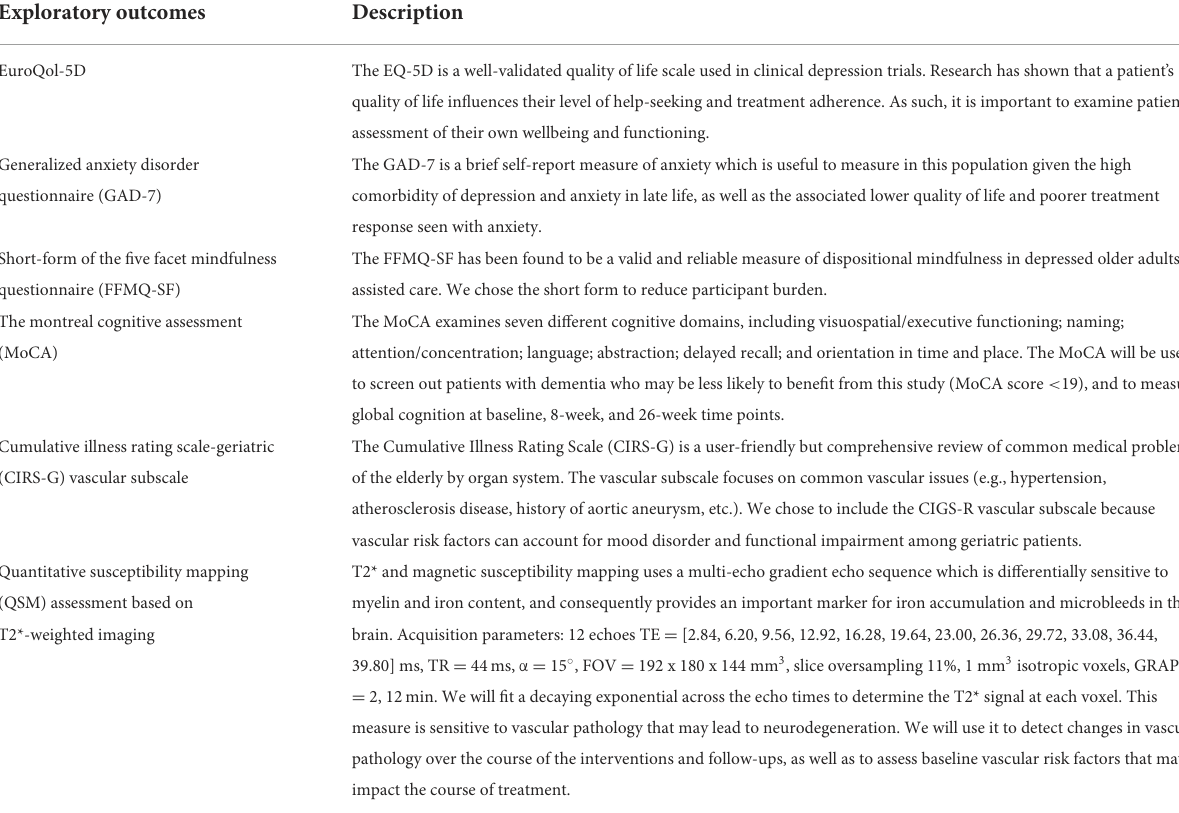
TABLE 1 Exploratory outcome measures for all participants, administered at 0 weeks (baseline), 8 weeks (end of intervention) and 26 weeks (follow-up). Exploratory